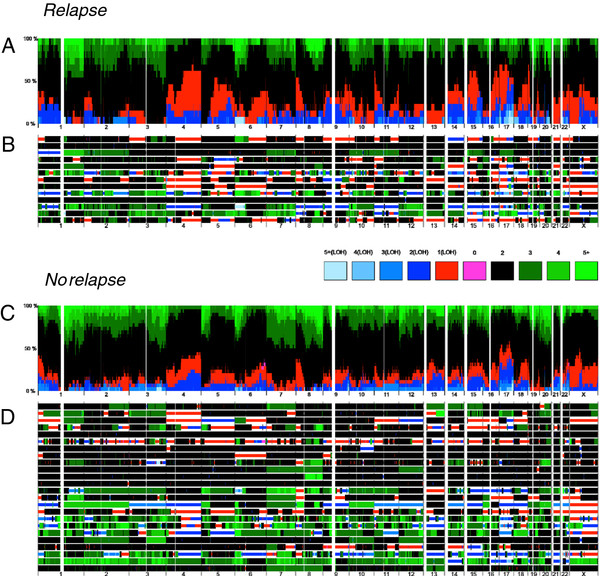
Allele-specific copy number analysis in early stage serous ovarian cancers across the genome. Frequency of aberrations with different total copy number and LOH in tumors with recurrent disease (A) and no recurrence (C). Individual total copy number and LOH for each tumor with recurrent disease (B) and no recurrence (D).